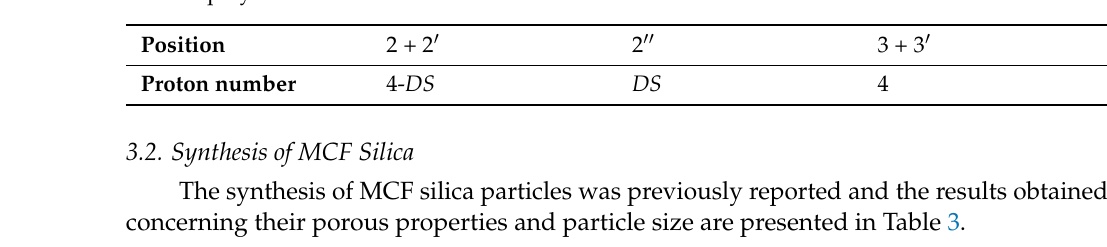
Table 2. Assignment of the positions and number of protons present in the structure of the sul- fonated polymers.